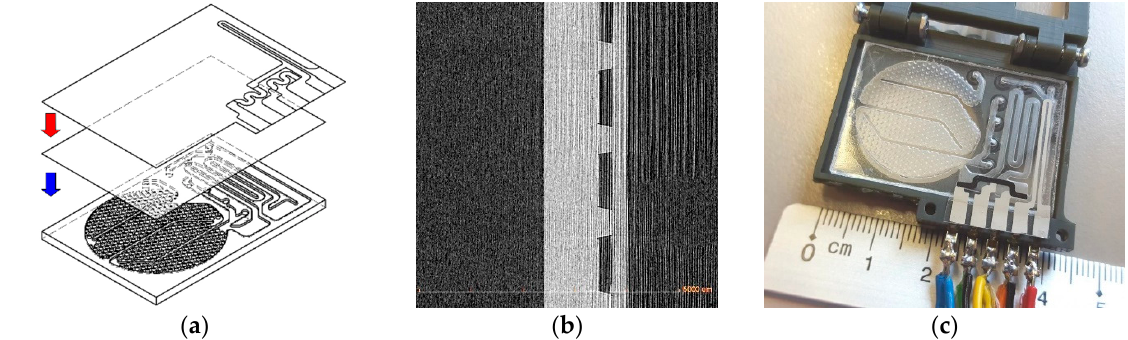
Figure 2. ( a ) Description of microfluidic closure: high temperature (red arrow), low temperature (blue arrow). ( b ) X-ray imaging across the cooling microchannels. ( c ) Sample of a manufactured chip on a test holder.